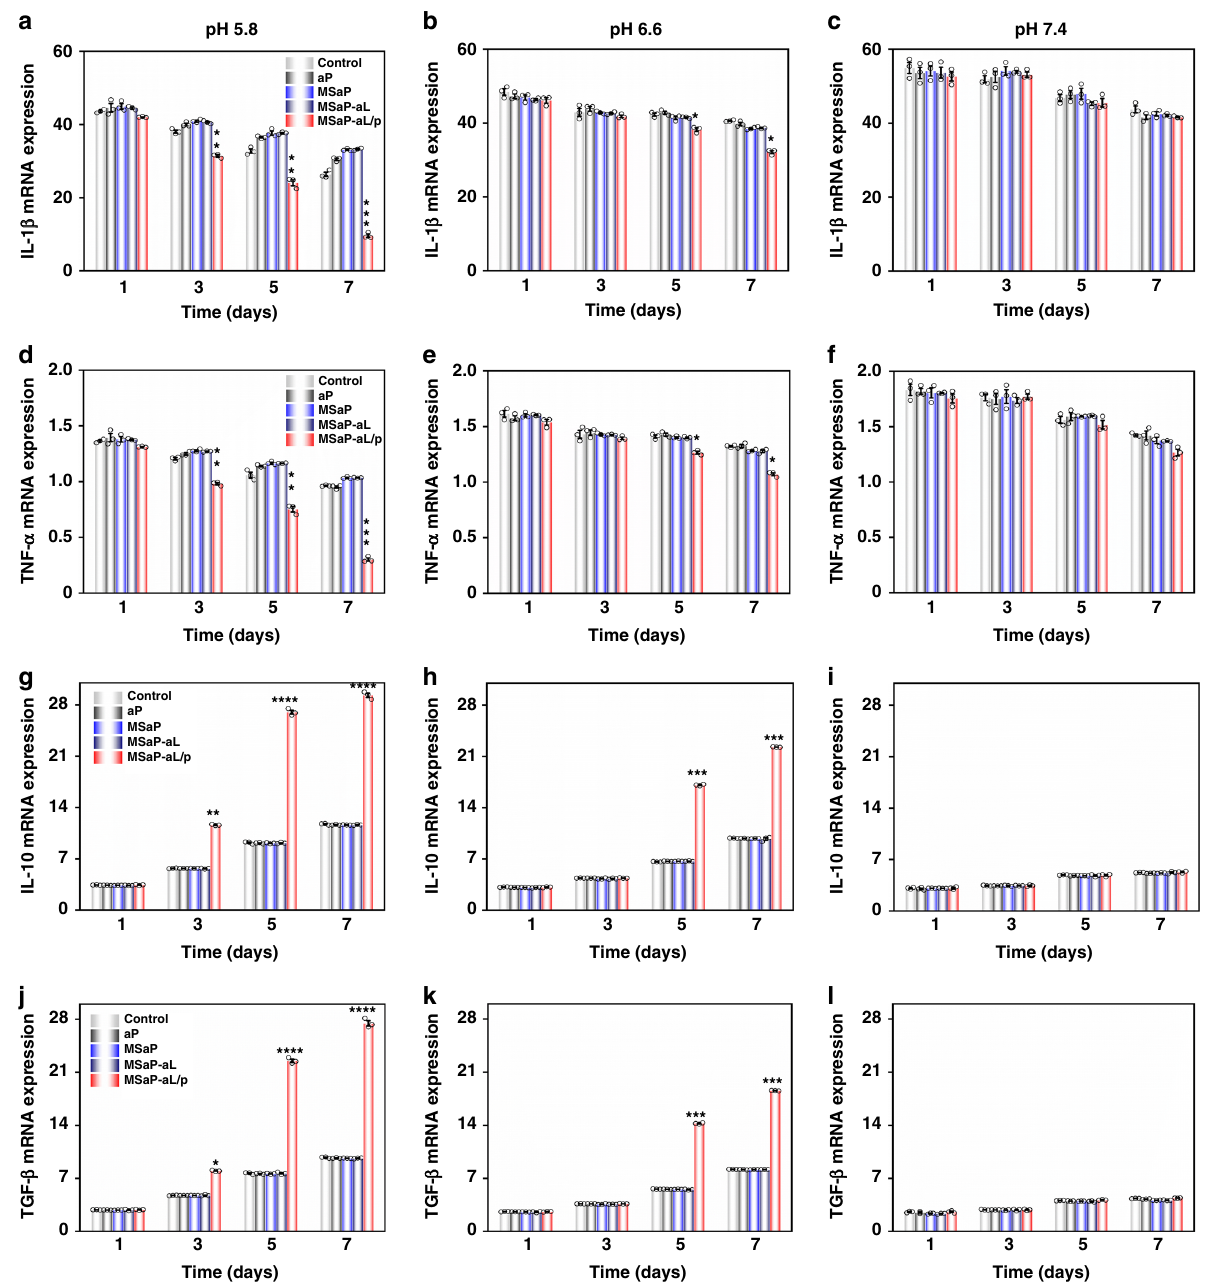
Fig. 6 Gene expression of BMMs in different pH culture environments. The expression of a – c IL-1 β mRNA, d – f TNF- α mRNA, g – i IL-10 mRNA, and j – l TGF- β mRNA at different pH of BMMs ( n = 3, all values were mean ± std. dev., * p < 0.05, ** p < 0.01, *** p < 0.001, and **** p < 0.0001 when comparing MSaP-aL/p and other groups via two-way analysis of variance (ANOVA) with Tukey ’ s post hoc